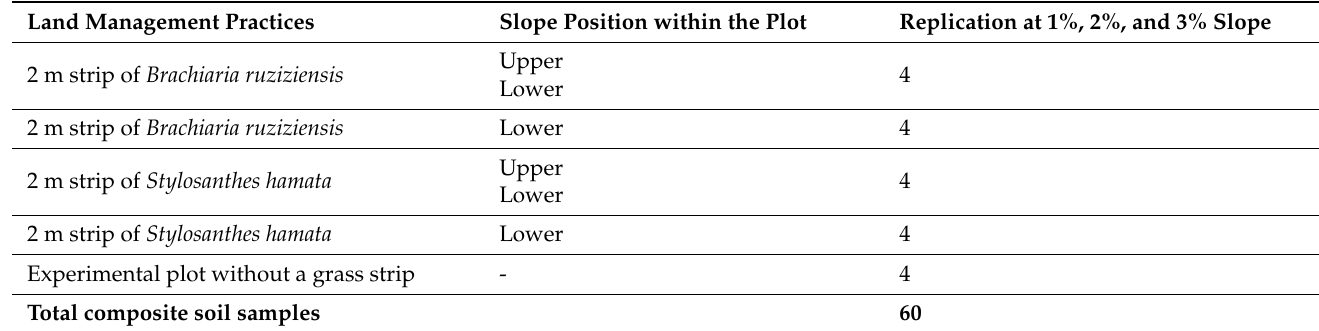
Table 1. Description of soil samples collected for laboratory analysis.